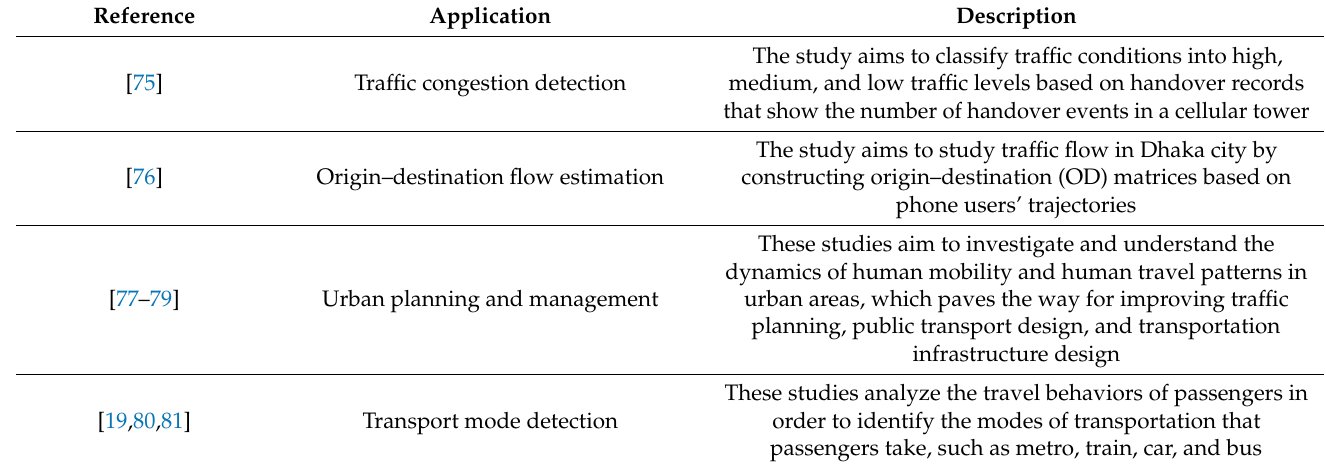
Table 4. List of transportation applications in mobile phone